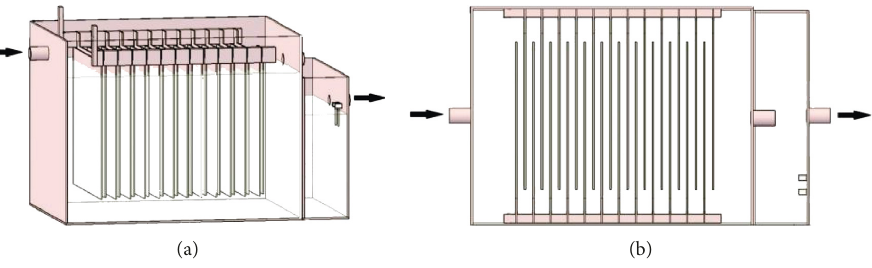
Figure 1: Scheme of electrocoagulation